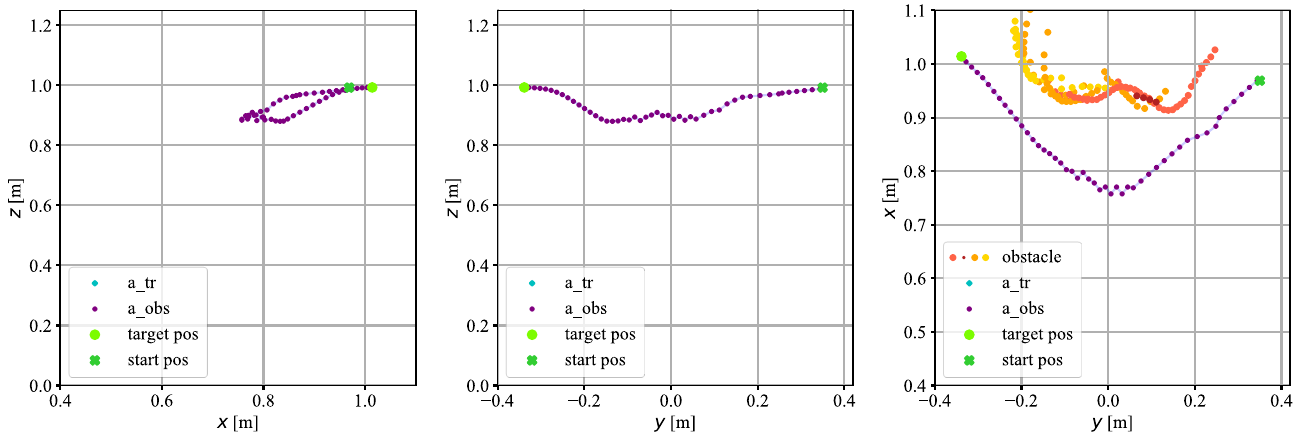
Figure 16. The trajectory on which the TCP of the robot moved in experimental research. Human as an obstacle.